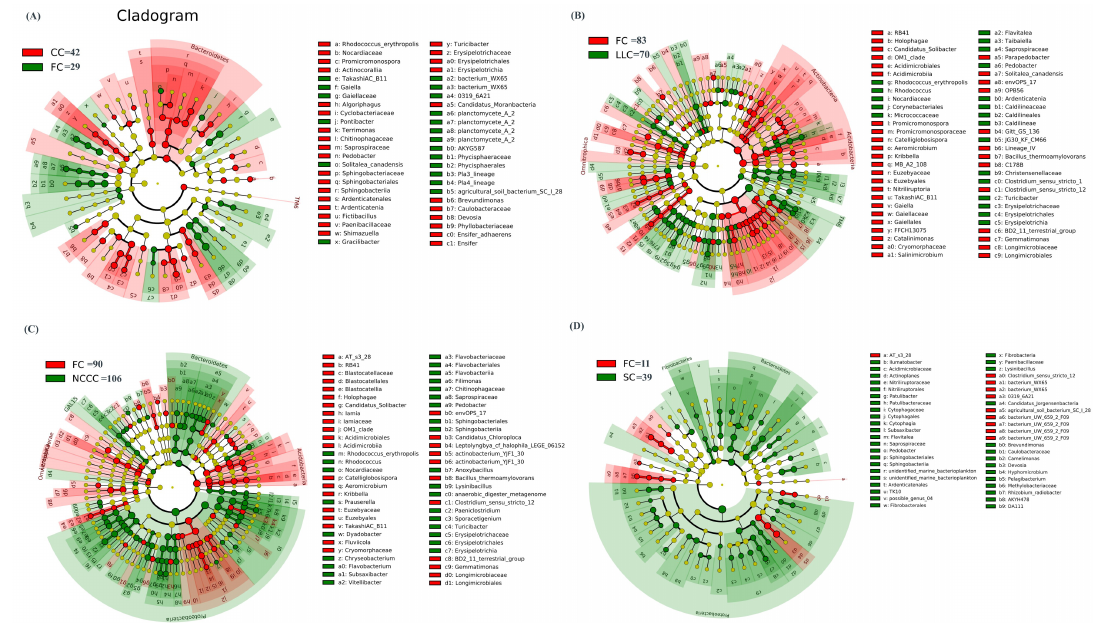
Figure 5. Cladogram plotted from LEfSe comparison analysis indicating the taxonomic representation of statistically and biologically consistent di ff erences of identified biomarkers among di ff erent cropping systems. ( A ) Spinach–cucumber vs. fallow–cucumber (CC-FC); ( B ) fallow–cucumber vs. leafy lettuce–cucumber (FC–LLC); ( C ) fallow–cucumber vs. non-heading Chinese cabbage–cucumber (FC–NCCC) and ( D ) fallow–cucumber vs. spinach–cucumber (FC–SC). The colored shadows represent trends of the significantly di ff ered taxa. The red or green shading depicts bacterial taxa that were significantly higher in each cropping system whereas species with no significant di ff erence are uniformly colored to